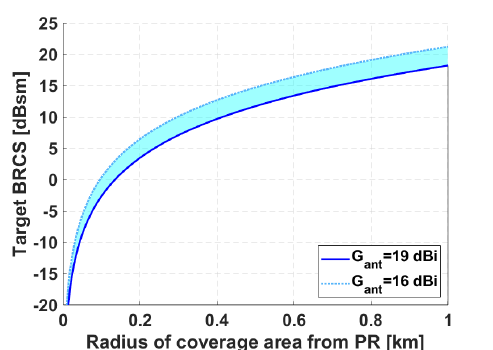
Figure 13. Curves of coverage ranges versus target BRCS for the measured antenna gain. System sensitivity equals − 148.5 dBm calculated for P D = 80% and P FA = 10 − 4 ( SNR DET = 16